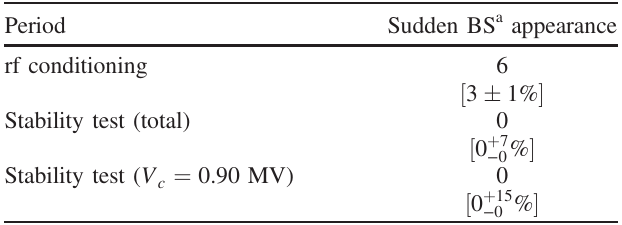
TABLE VI. Number of cavity breakdown events accompanied by the sudden appearance of a new bright spot immediately before the cavity breakdown. Numbers enclosed in square brackets are percentages of the total numbers of cavity break- down events with binomial errors for a 1 σ confidence